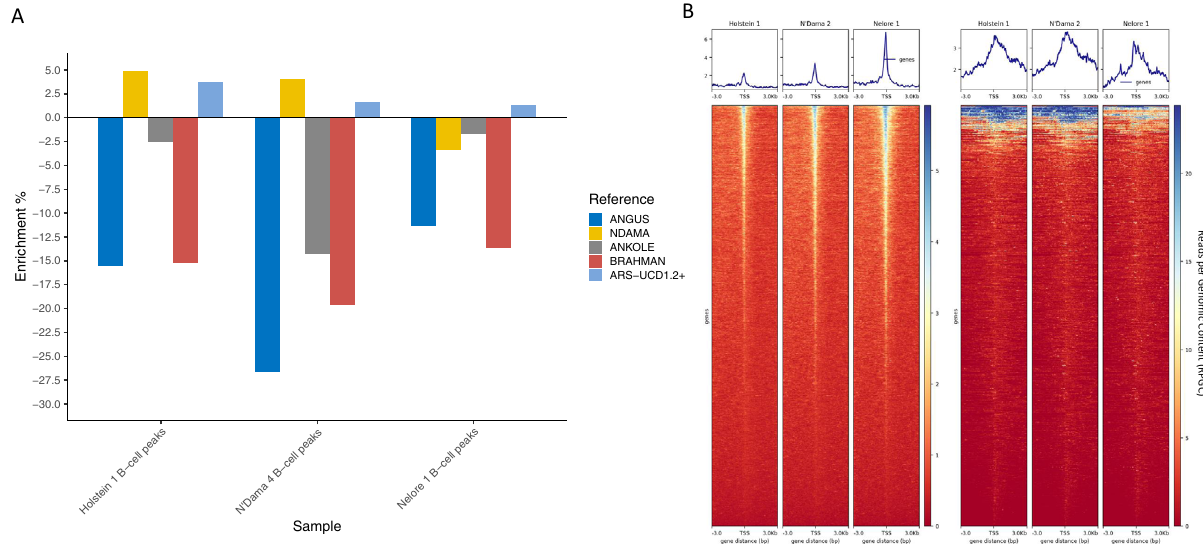
Fig. 6 ATAC-seq analyses results. A Enrichment or depletion of the number of ATAC-seq peaks called in the different assemblies with respect to the number called in ARS-UCD1.2, showing more peaks were called using the expanded ARS-UCD1.2 + genome in all samples; and B showing the enrichment around the TSS of both the ARS-UCD1.2 annotated genes (left three heatmaps) and of the 923 features predicted by Augustus in the novel contigs (right). The source data for panel ( A ) are provided with the Table 5). This increase is con fi rmed also when using only Peak calling on the ARS-UCD1.2 + genome returned up to uniquely mapped reads, with the ARS-UCD1.2 + calling con- 3.7% more peaks when compared to the ARS-UCD1.2 genome at sistently more peaks than the standard ARS-UCD1.2 (Supple- the same signi fi cance thresholds despite ARS-UCD1.2 being only mentary Table 6). 0.7% longer. This expanded genome worked particularly well for